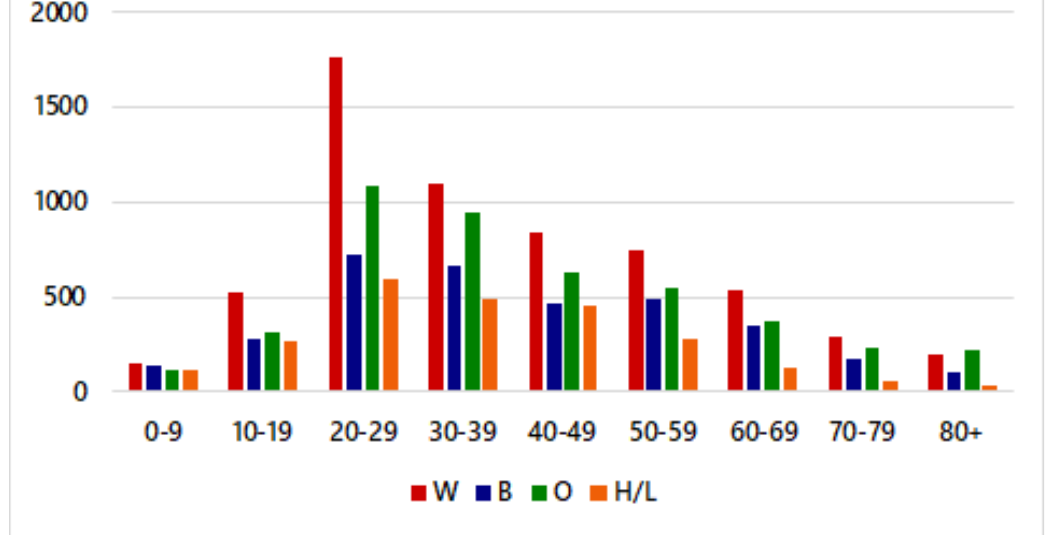
Figure 2. Crude COVID-19 cases by age & race/ethnicity in Kansas City, MO, from March to November 2020.